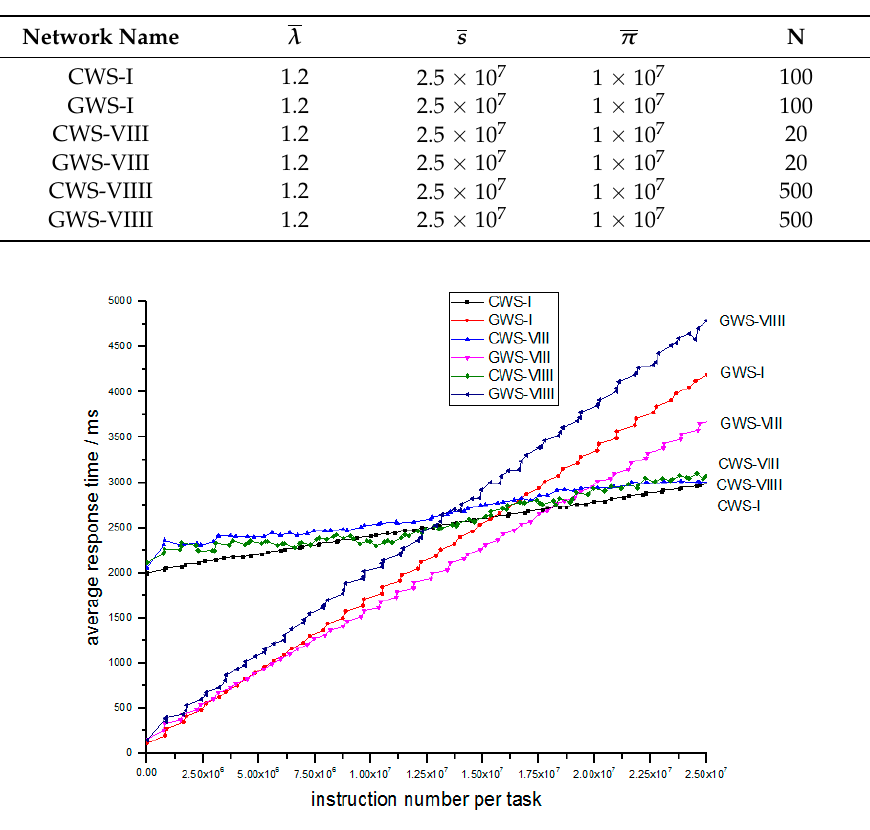
Figure 14. Relation of average response time and number of instructions per task between different FCN